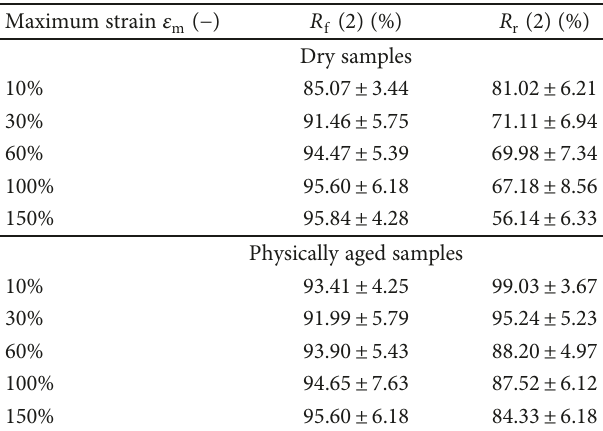
Table 5: Shape-memory properties of dry and physically (hydrolytically) aged Estane programmed at θ = 70 ° C . The results for the fi rst cycle can be found in Supplement I.